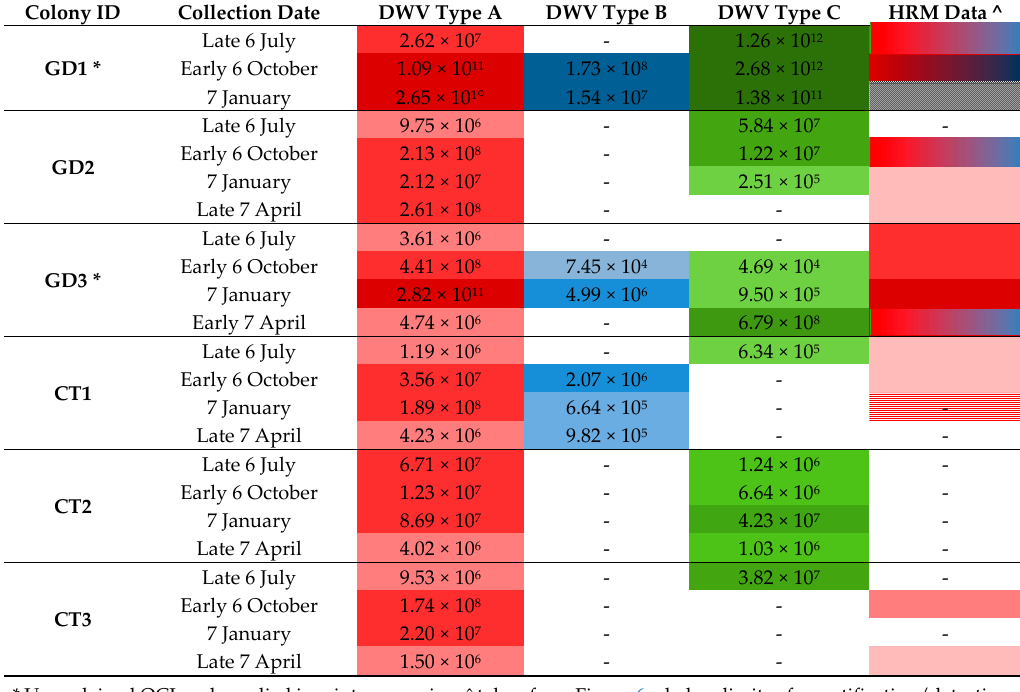
* Unexplained OCL, colony died in winter or spring; ^ taken from Figure 6; - below limits of quantification/detection;